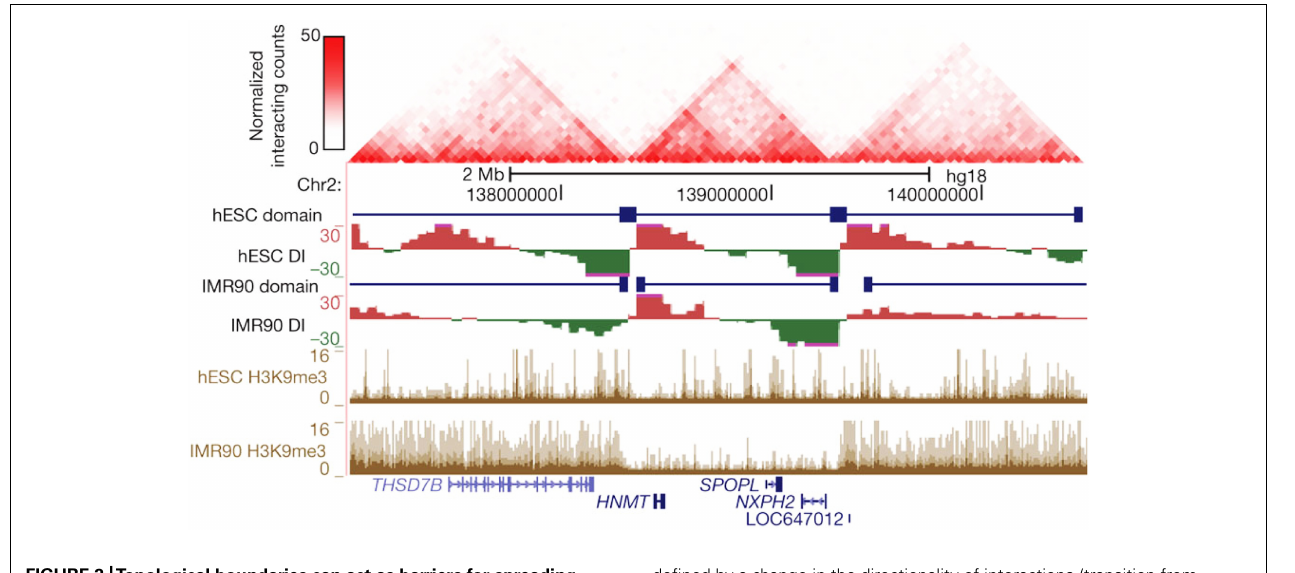
FIGURE 2 |Topological boundaries can act as barriers for spreading of heterochromatin. The 2D heat map shows the Hi-C interaction frequency in human ES cells. Underneath is indicated the directionality index (DI) in hESCs and IMR90 cells.The DI is a Hi-C measure showing a site’s preference to engage in unidirectional contacts with downstream (red) or upstream (green) sequences. Borders of the topological domains are